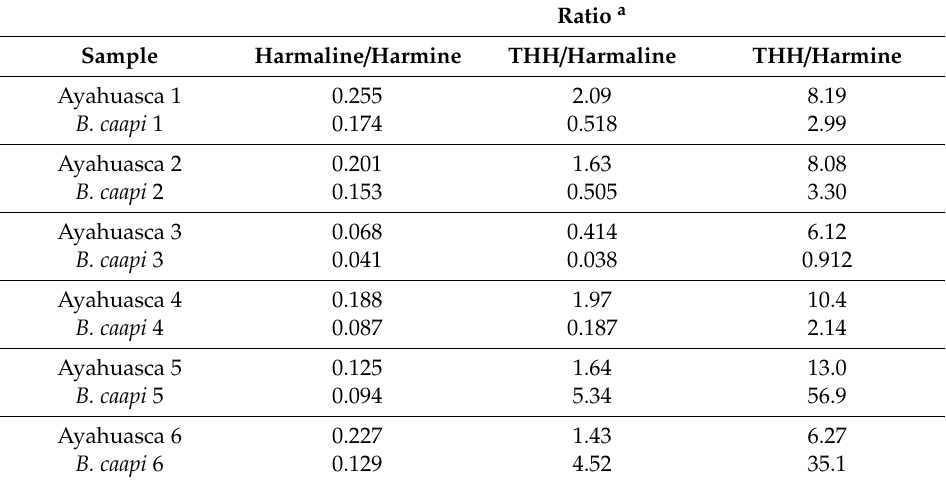
Table 2. β -carboline ratios found in six ayahuasca samples and in the respective samples of B. caapi used in the